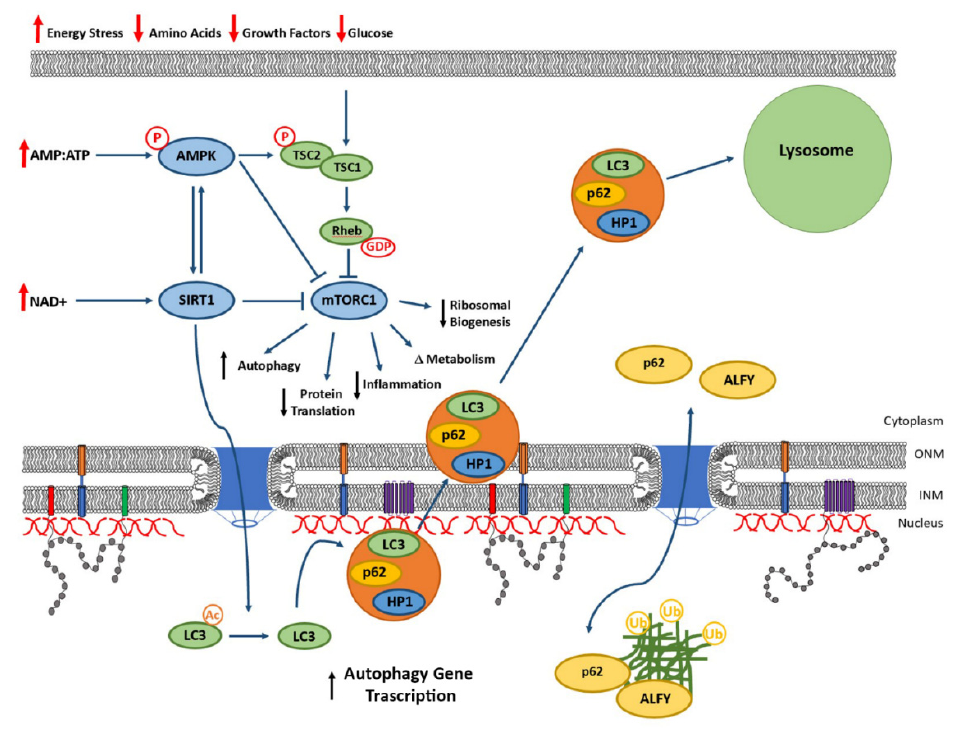
Figure 5. Linking lamina protein levels with cellular energy sensing. Schematic representation of the link between cellular energy sensing pathways (Sirtuin1 deacetylase (SIRT1) and adenosine mono-phosphate kinase (AMPK)) and mammalian target of rapamycin complex 1 (mTORC1). Increased levels of NAD+ and AMP upregulate SIRT1 and AMPK, respectively leading to downregulation of mTORC1 function. Decreases in growth factors and amino acids also downregulate mTORC1 function. Downstream functions of mTORC1 are indicated. SIRT1 interactions with LC3 are also indicated, leading to the formation of LC3, p62 and HP1 containing vesicles carrying cargo to lysosomes. This also leads to p62 and ALFY binding ubiquitinated cargo for nuclear export.